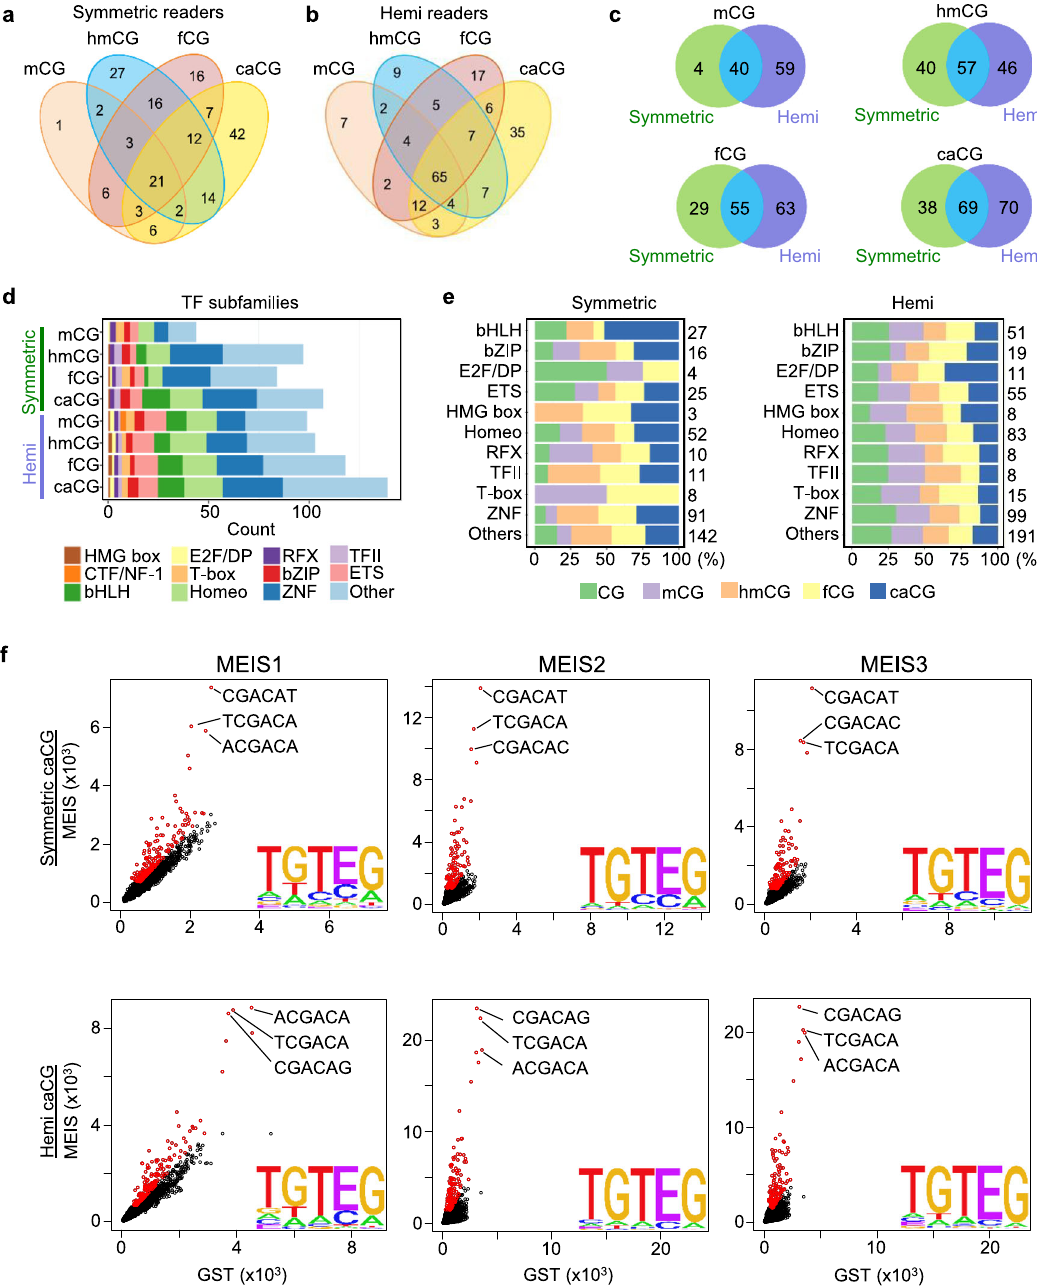
Fig. 3 Identi fi cation of readers for various epigenetic modi fi cations. a Venn diagram analysis of identi fi ed readers for mC, hmC, fC, and caC modi fi cations in symmetric form. b Venn diagram analysis of identi fi ed readers for mC, hmC, fC, and caC modi fi cations in hemi- form. c Venn diagram analysis between symmetric and hemi-modi fi cation readers in the context of mCpG, hmCpG, fCpG, and caCpG modi fi cations. d The identi fi ed binding activities to both symmetric and hemi-mC, -hmC, -fC, and -caC modi fi cations are observed for all the major TF subfamilies shown in different colors. More TFs were found to interact with hemi-modi fi ed DNA consensus sequences than symmetrically modi fi ed sequences. e No signi fi cant preference to a particular symmetric or hemi-modi fi cation was observed within each major TF subfamily shown in different colors. f Highly conserved homologs often recognized highly similar consensus sequences and shared the preference for the same modi fi cations. For example, MEIS1/2/3 all recognized a similar consensus carrying caC in a sequence of 5 ′ -TGTcaCG in both symmetric and hemi-forms. The scatterplots display the frequencies of 6-mer subsequences obtained with the MEIS1/2/3 ( y- axis) and GST tag control ( x -axis). Letter E in the consensus sequences represents caC. The top three 6-mer sequences are highlighted. Source data are provided as a Source Data fi